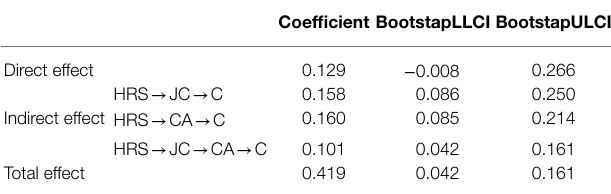
TABLE 4 | The serial mediating effect test. Coefficient BootstapLLCI